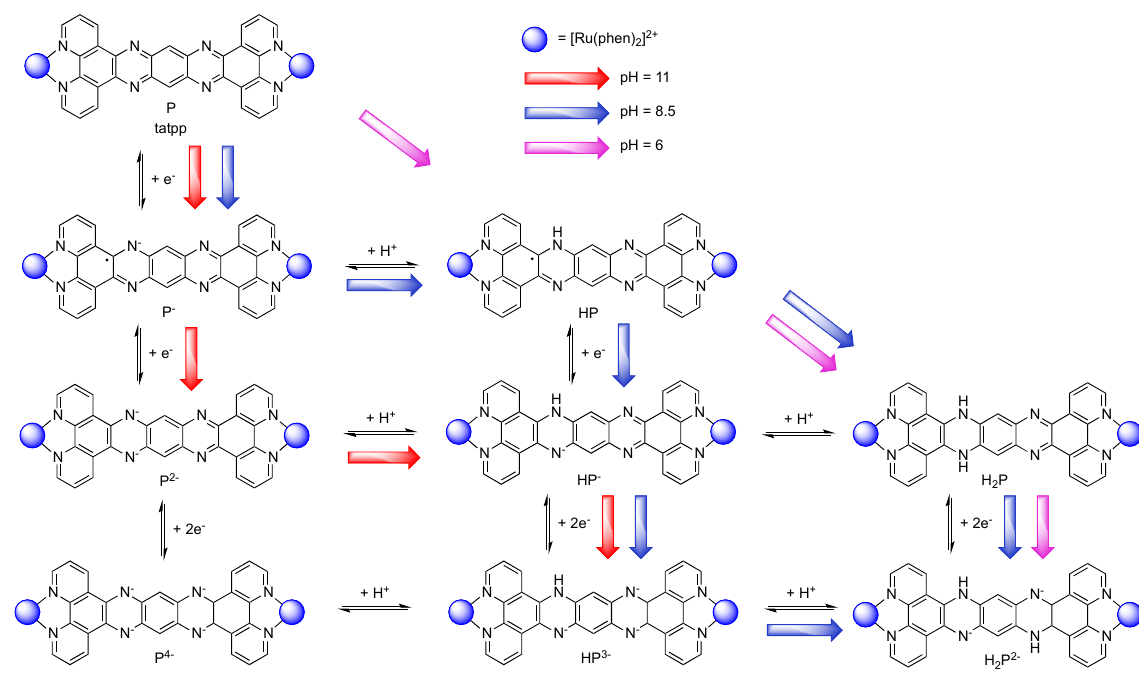
isomers of [Ru(phen)